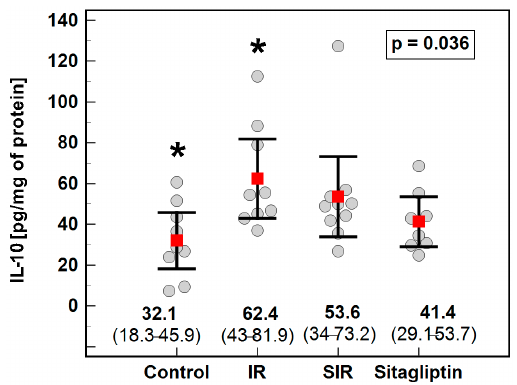
Figure 3. Effect of ischemia/reperfusion injury and sitagliptin on hepatic concentration of IL-10. Data are presented as means with 95% confidence interval (CI), analyzed with one-way ANOVA. Significant ( p < 0.05) between-group difference is marked by *. IR, ischemia/reperfusion group; SIR, ischemia/reperfusion group pretreated with sitagliptin.